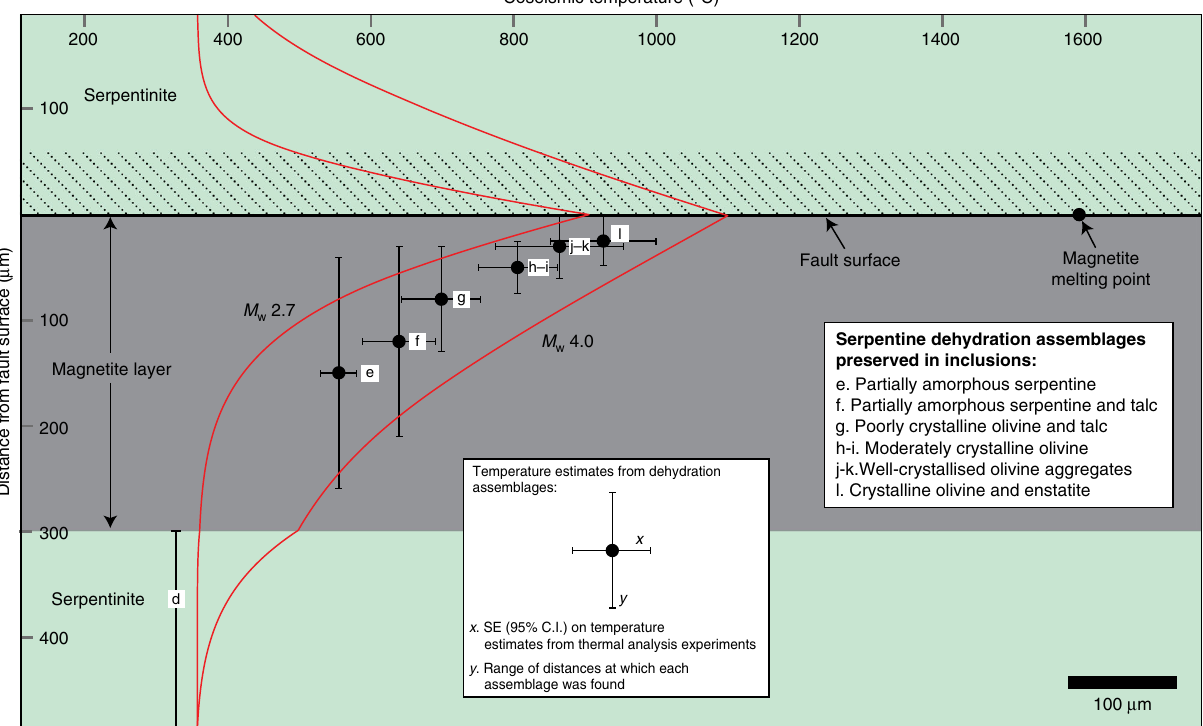
Fig. 3 Results of fi nite-element modelling and summary of temperature estimates for dehydration products. Points lettered (e) to (l) represent the locations of serpentinite inclusions and the temperature estimates for the dehydration assemblages found within each inclusion (shown in Fig. 2). Region (d) is the estimated ambient temperature (350 °C) in the foliated serpentinite shear zone (see Methods). X error bars represent the SE (with a 95% con fi dence interval) of the mean temperature reported for each dehydration assemblage in the literature (see Supplementary Table 1). Y bars represent the range of distances over which each dehydration assemblage was found during TEM examination. The melting point of magnetite is also indicated. The red curves show the modelled temperature pulse resulting from frictional heating during earthquakes of M w 2.7 and M w 4.0, which are compatible with the petrological constraints on the dehydration sequence. The hatched area shows the layer of serpentinite that is predicted to dehydrate for a M w 2.7 earthquake, although the dehydration products in this layer would rapidly be converted back in to serpentine. The same layer would be ca. 160 μ m thick